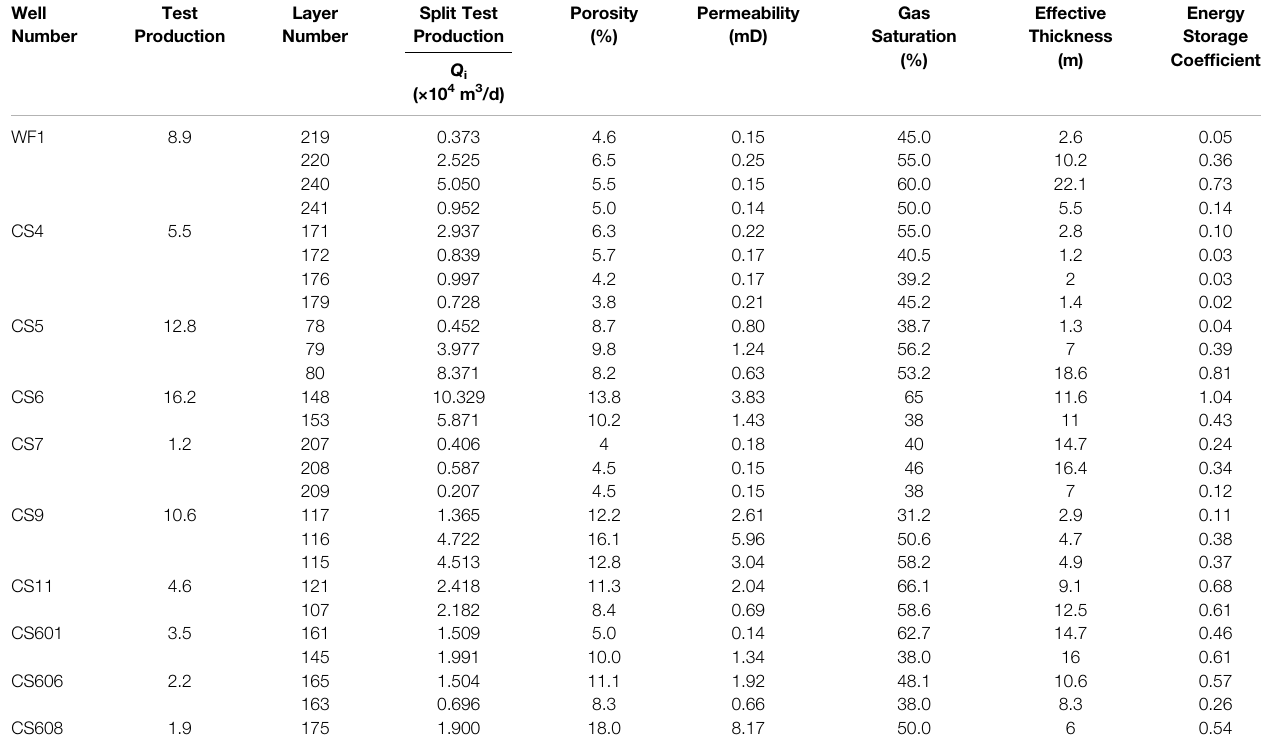
TABLE 2 | Statistics of the production capacity and sensitivity parameters of the Wangfu gas fi eld reservoir. Well Test Number